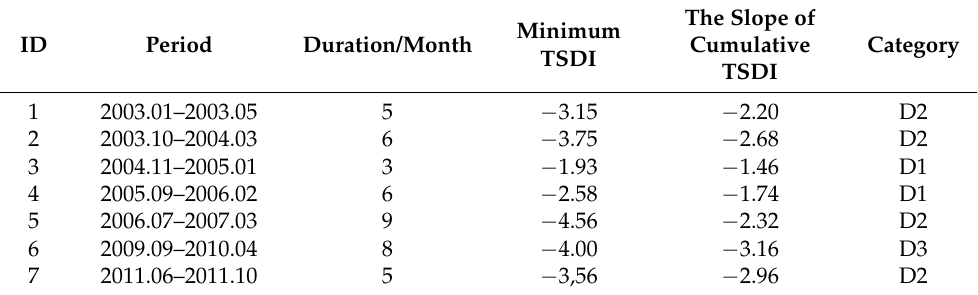
Table 2. Statistics of TSDI-identified drought